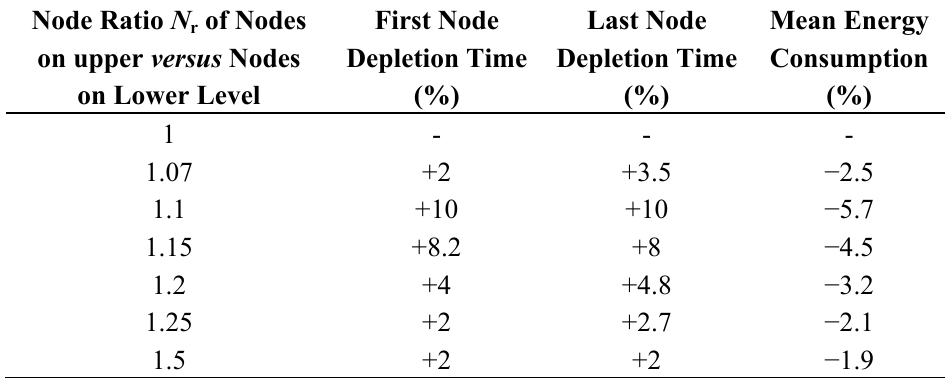
Table 2. Percentage of change in WSN performance by the use of ECHERP as a function when the base station is located 150 m away the center of the of the node ratio N r sensor field.